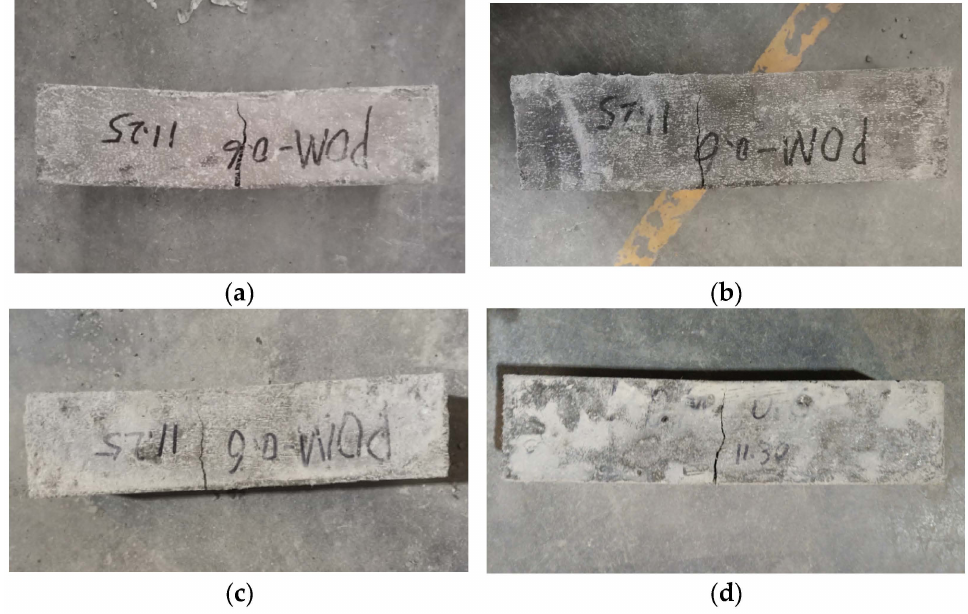
Figure 23. Failure performance of flexural test for POM0.6 SWSSC specimens with different ages: ( a ) 3 d; ( b ) 7 d; ( c ) 14 d; and ( d ) 28